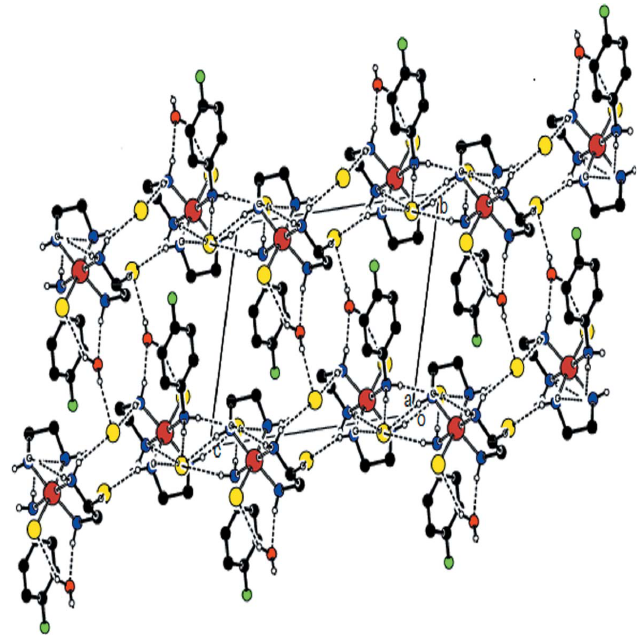
Figure 2 View of the three-dimensional hydrogen-bonded network of